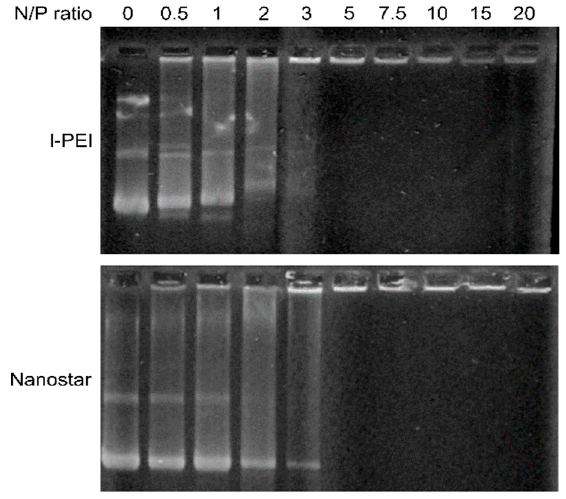
Figure 2. Gel retardation of the polyplexes as a function of the N/P ratio (indicated on the top of the respective lanes).